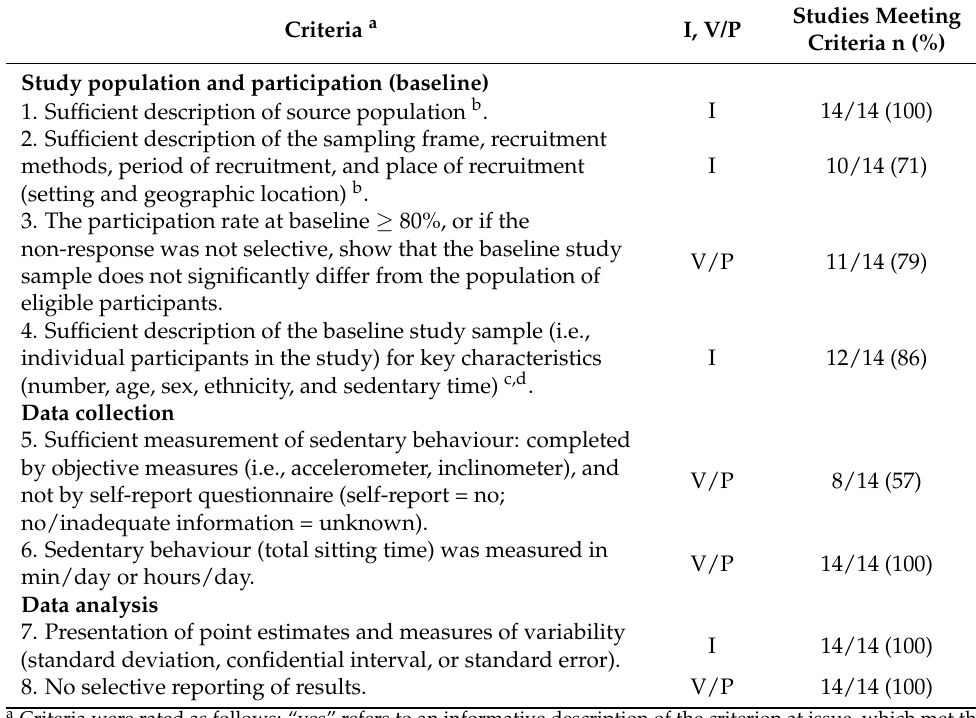
Table 1. Methodologic quality assessment of the included